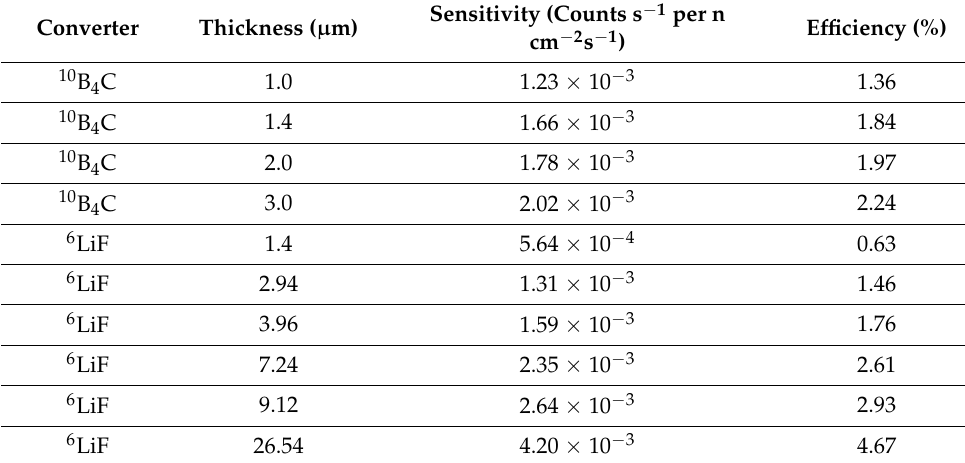
Table 2. 4H-SiC SBD detector (3 mm × 3 mm) efficiency for different thermal neutron converter